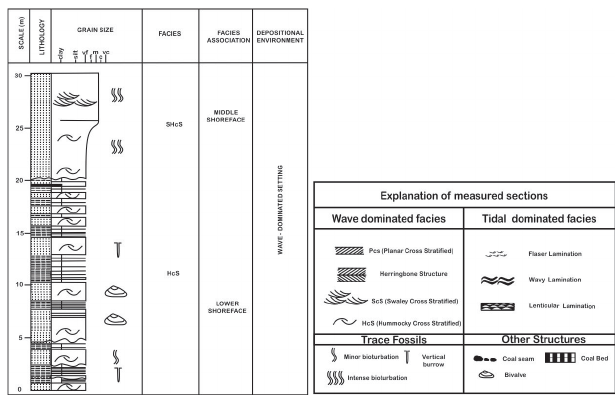
Figure 9: Schematic diagram of litholog from Hospital road outcrop showing facies 3 and 4. 5. ENVIRONMENTAL INTERPRETATION AND MODEL OF WAVE DOMINATED